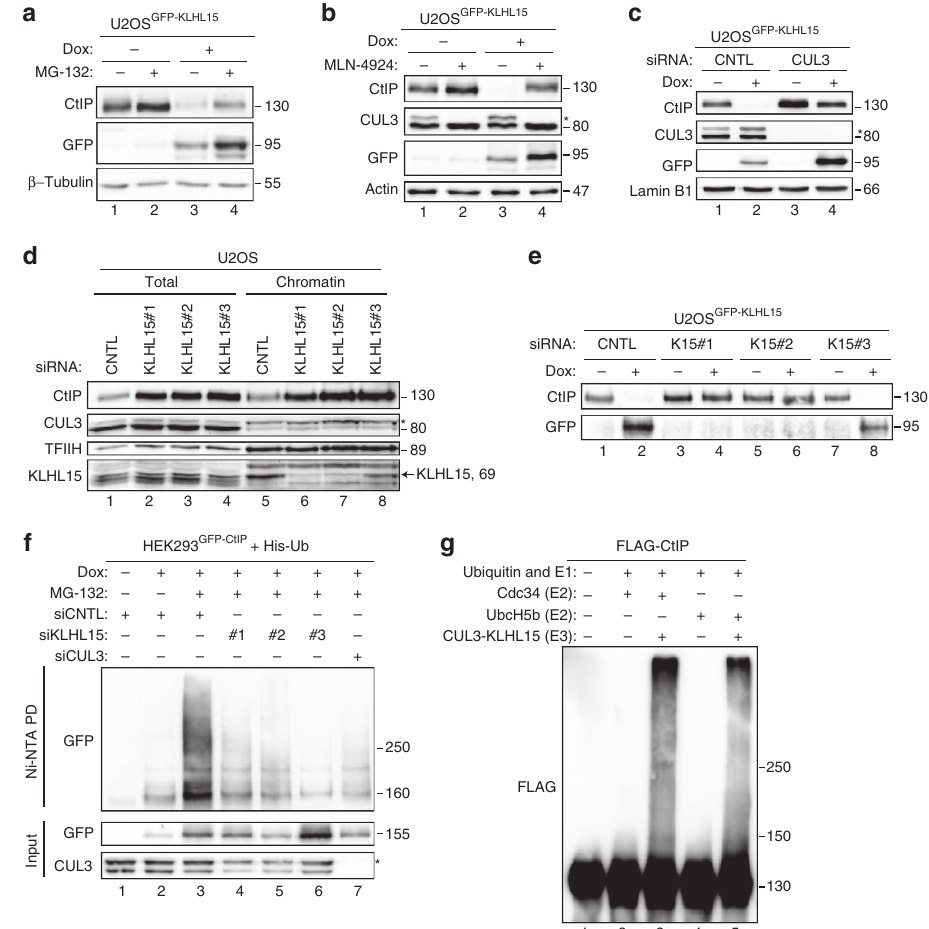
Figure 2 | CUL3-KLHL15 E3 ligase promotes CtIP protein turnover via the ubiquitin-proteasome pathway. ( a ) U2OS Flp-In T-REx cells stably expressing doxycycline (Dox)-inducible GFP-KLHL15-wt were cultivated in the absence ( (cid:2) ) or presence ( þ ) of Dox. Twenty-four hours post induction, cells were either mock-treated or treated with MG-132 (10 m M) for 6h and whole-cell lysates were analysed by immunoblotting. ( b ) Twenty-four hours post induction, same cells as in a were either mock-treated or treated with MLN-4924 (100nM) for 8h and whole-cell lysates were analysed by immunoblotting. ( c ) Same cells as in a were transfected with either non-targeting (CNTL) or CUL3 siRNA oligos. 48h later, GFP-KLHL15 expression was induced with Dox for 24h and whole-cell lysates were analysed by immunoblotting. ( d ) U2OS cells were transfected with the indicated siRNA oligos for 48h. Total cell extracts and chromatin-enriched fractions were analysed by immunoblotting using the indicated antibodies. ( e ) Same cells as in a were transfected with the indicated siRNA oligos. Twenty-four hours post transfection, cells were grown for 24h in the absence ( (cid:2) ) or presence ( þ ) of Dox and whole-cell lysates were analysed by immunoblotting. ( f ) HEK293 Flp-In T-REx cells inducibly expressing GFP-CtIP were transfected with the indicated siRNAs. Forty-eight hours later, cells were transfected with His-Ub and the expression of CtIP was simultaneously induced with Dox. Eight hours post induction, cells were transfected with siRNAs for a second time. Three days after the first siRNA transfection, cells were treated with MG-132 (20 m M) for 6h followed by lysis in buffer containing guanidium-HCl. Ubiquitin conjugates were pulled-down (PD) with Ni-NTA-agarose beads, eluted and analysed by immunoblotting with anti-GFP antibody. ( g ) Recombinant FLAG-CtIP was incubated with ATP, ubiquitin, E1, E2 enzymes and CUL3-N8/RBX1-KLHL15 (E3) for 30min at 37 (cid:2) C. Unmodified and ubiquitinated CtIP protein species were detected by immunoblotting with anti-FLAG antibody. Asterisks indicate neddylated